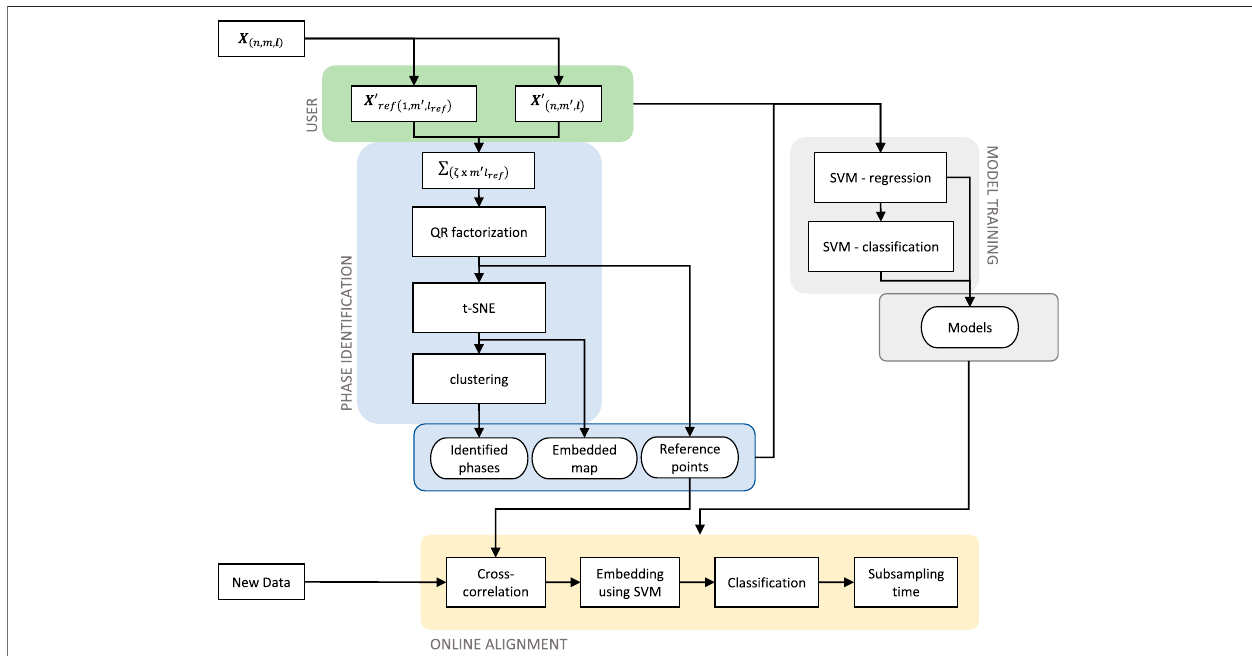
FIGURE 1 | Architecture of the method for automated phase identi fi cation and alignment.